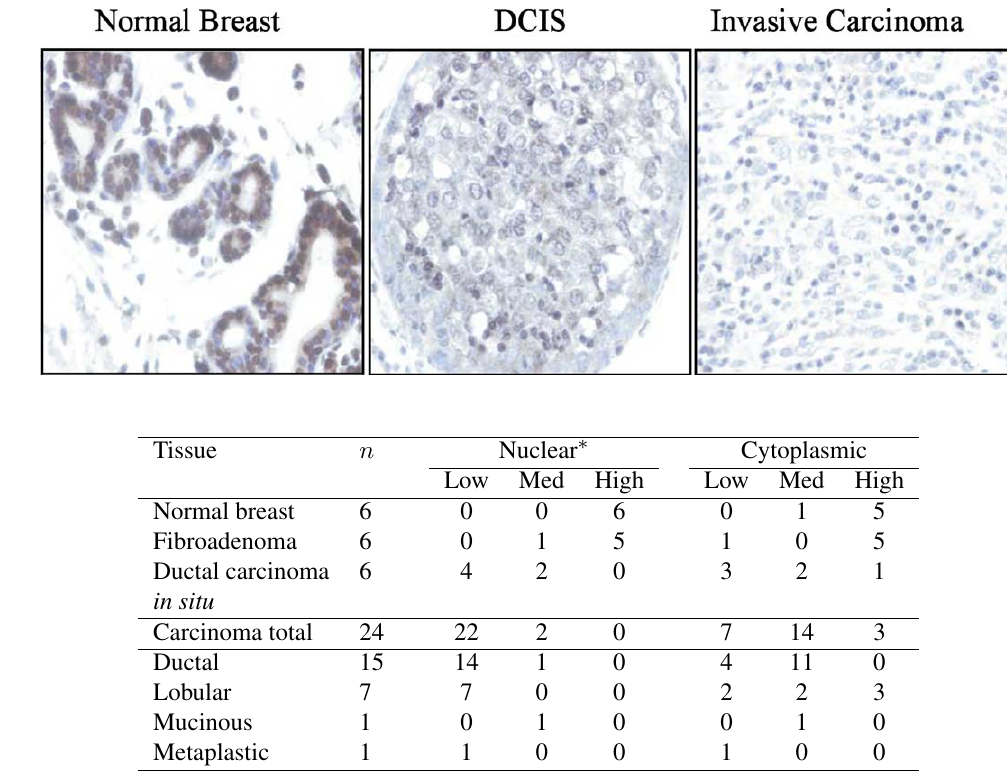
Fig. 3. Immunohistochemical detection of HOXA5 in breast tissues. Representative photomicrographs of sections of breast tissue stained with a 1:250 dilution of polyclonal anti-HOXA5 antibody. A. Paraffin-embedded tissues from normal breast (note intense nuclear, and diffuse cytoplas- mic staining of epithelial and myoepithelial cells, stromal cells, and lymphocytes), ductal carcinoma in situ and invasive poorly differentiated ductal carcinoma (remarkably light staining in carcinoma cells compared to dark staining in nucleus of normal breast epithelial cells). B. Analysis of the HOXA5 expression levels in the normal breast tissues and the different breast carcinomas. Immunoperoxidase staining was assessed in more than 300 cells and the numerical values are as follows: low-0 to < 20% of cell showed staining; med – > 20% to < 50% of cell showed staining; high – > 50% of cell showed